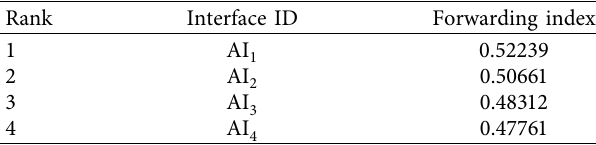
Table 6: Forwarding index ranking for interface